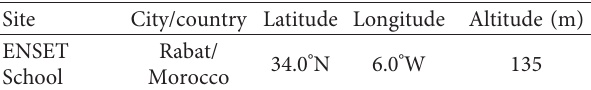
Figure 2: The photo of the DC and AC equipment of the PV system of 2 kWp located at Rabat city of Morocco. (a) The grid-tied in- verter (SMA Sunny Boy 2000 HF). (b) The junction box for grid- tied part, which holds the circuit breaker. (c) The junction box for off-grid part, which contains the circuit breaker. (d) The inverter/ charger, which is doted by the options of voltage control, battery charger, and inverter (Victron Energy). (e) The bank of waterproof gel batteries (12V-220 Ah) of Victron Energy brand. (f) The gear, which is used for monitoring the PV system and data registering (Solar Log 1200). Table 1: The PV system geographical